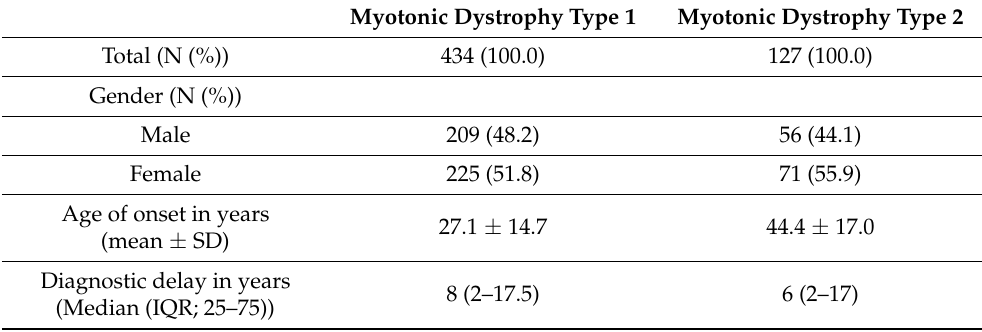
Table 1. Main characteristics of subjects.